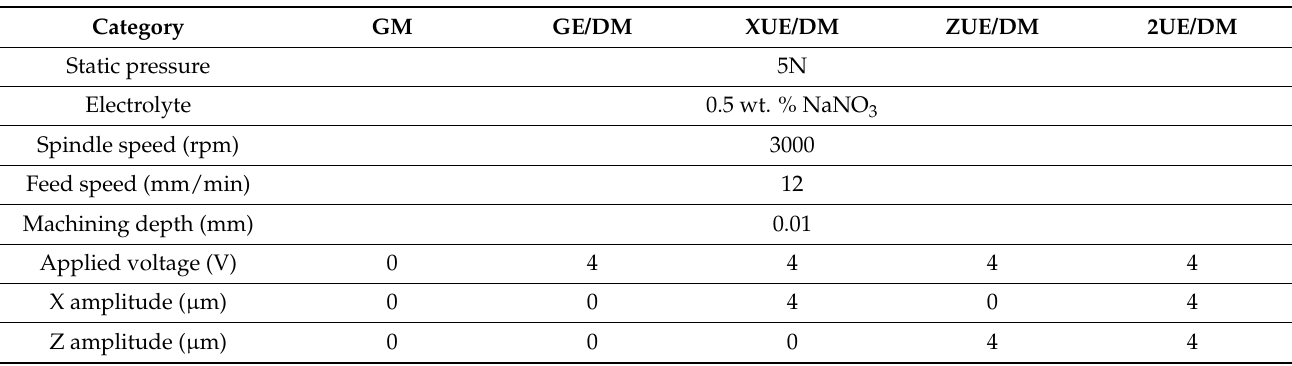
Table 2. Machining conditions for the mechanism.